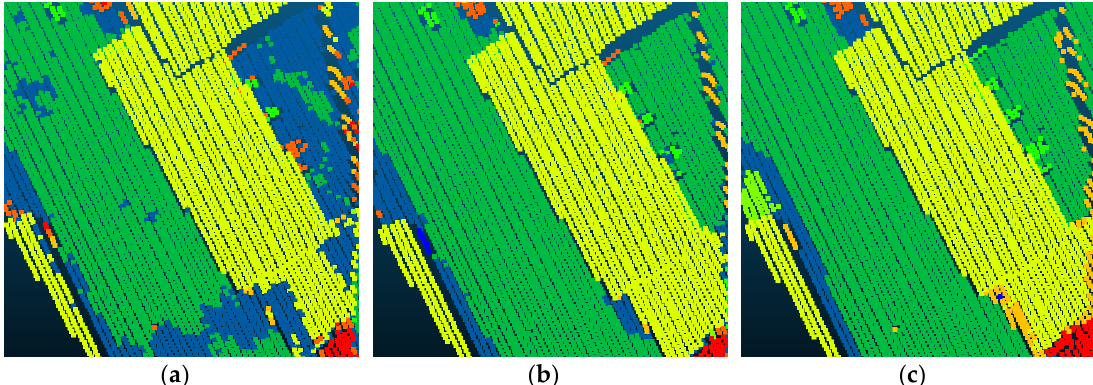
Figure 7. The detailed improvement of low vegetation and impervious surfaces classification. ( a ) The Point_S result. ( b ) The SegT_M result. ( c ) The ground truth.